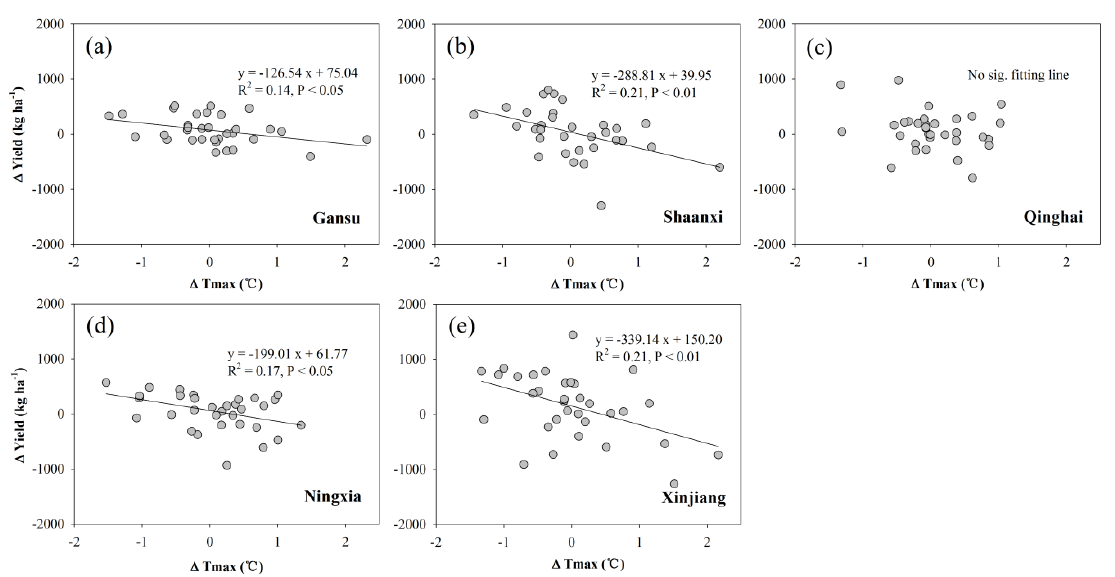
Figure 5. Relationships between changes in the daily maximum temperature and potato yield in different provinces of northwest China.